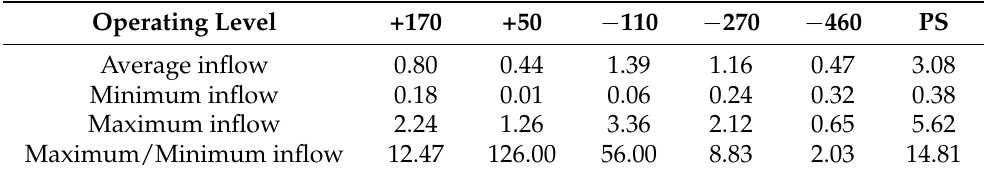
Table 3. Inflow (m 3 /min) to the Slupiec mine workings for the period 1968–1990 [34]. No data available for level − 515. PS—inflow to the pump station.